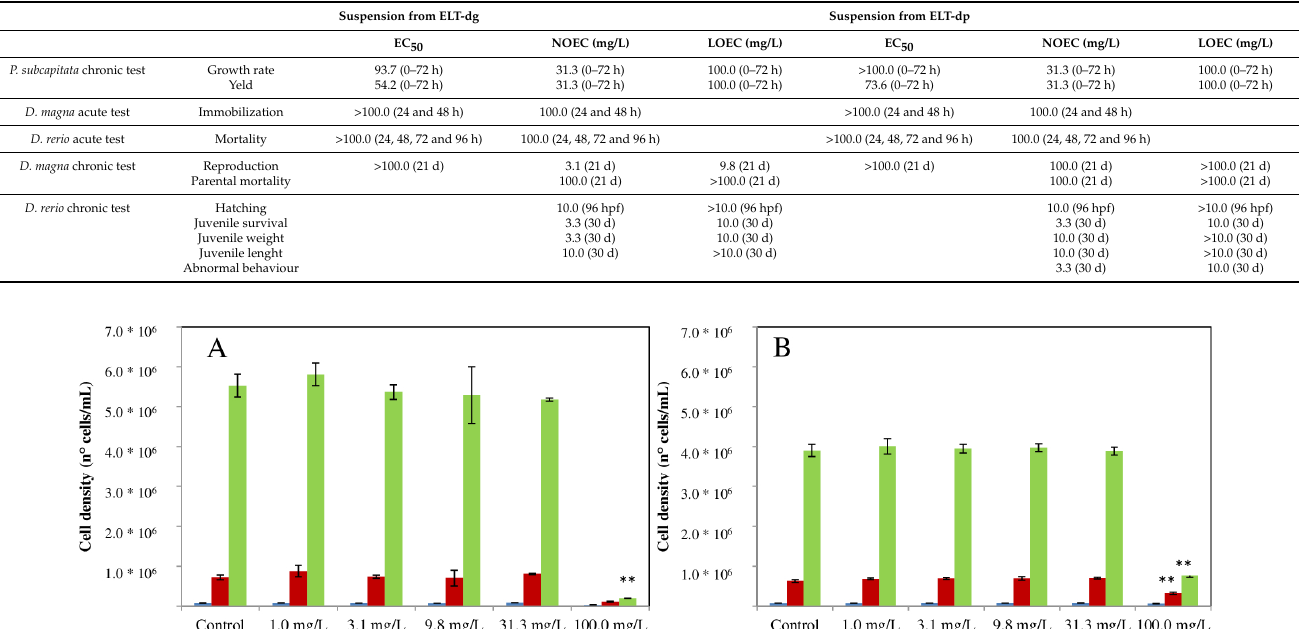
Figure 4. Significant effects indicated by asterisks (** p < 0.01), control versus treated, induced by both ELT-dg ( A ) and ELT-dp ( B ) suspensions in P. subcapitata (cell density) at 24 (blue bars), 48 (red bars) and 72 h (green